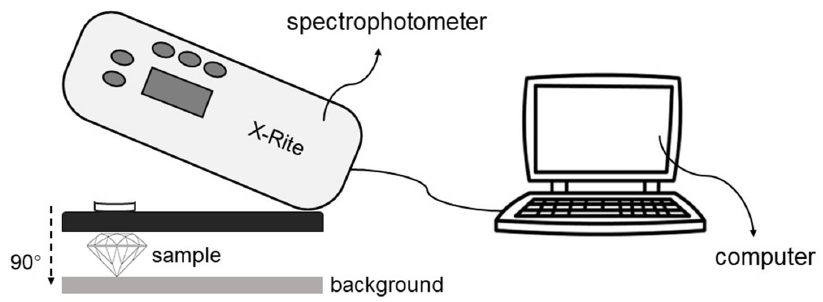
Figure 2. The color measurement device for this experiment.